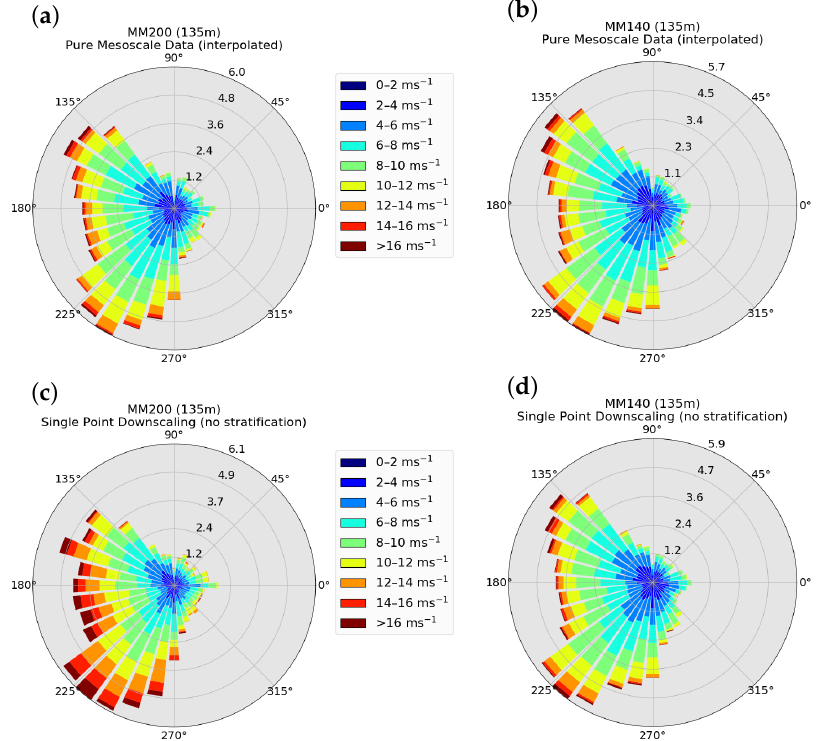
Figure 8. Comparison of different wind roses at Rödeser Berg: ( a ) wind rose from meso-scale data of NEWA database (grid point closest to MM200), ( b ) wind rose from meso-scale data of NEWA (grid point closest to MM140), ( c ) single point downscaled data based on meso-scale data of ( a ) (at MM200, neutral micro-scale CFD only) ( d ) single point downscaled data based on meso-scale data of ( b ) (at MM140, neutral micro-scale CFD